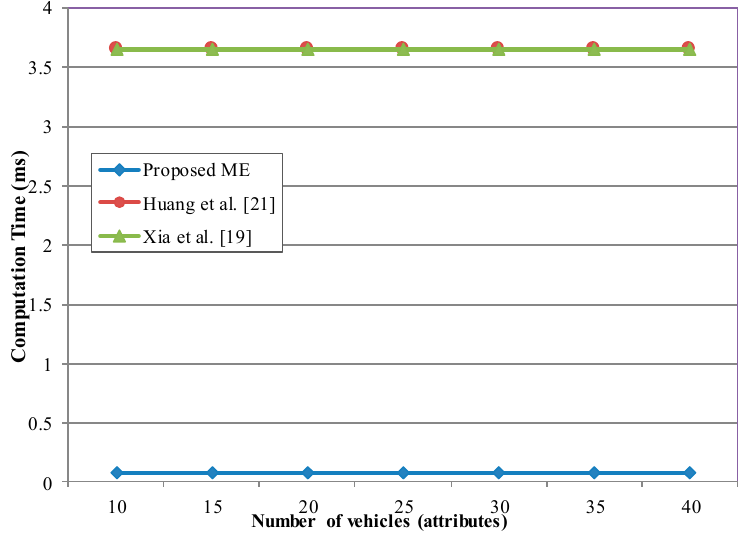
Figure 15. Computation cost of message decryption.